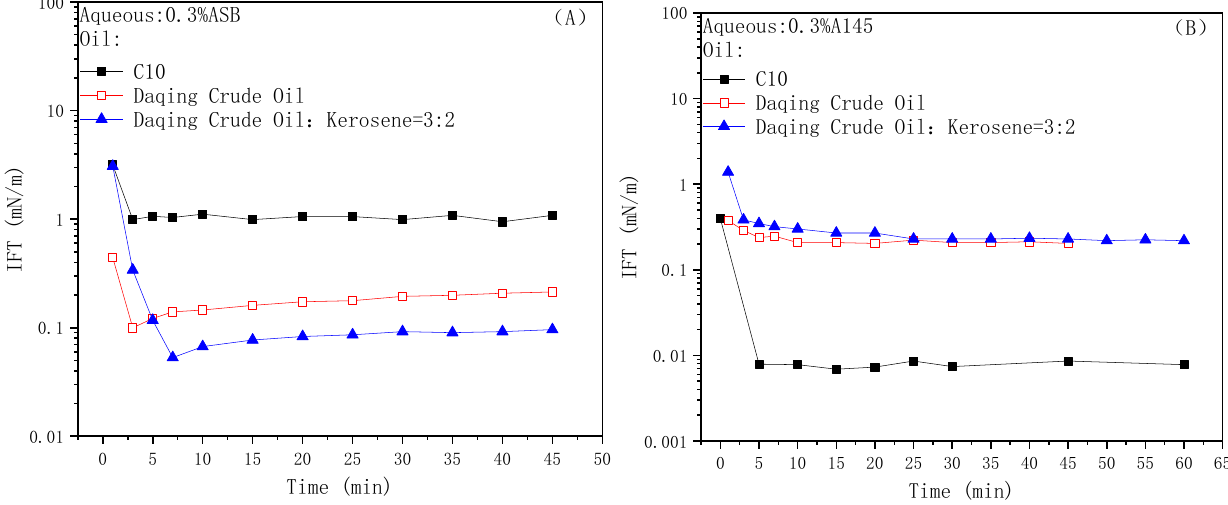
Figure 1. Dynamic IFTs of ASB ( A ) and A145 ( B ) solutions against n-decane, Daqing crude oil and Daqing diluted oil.